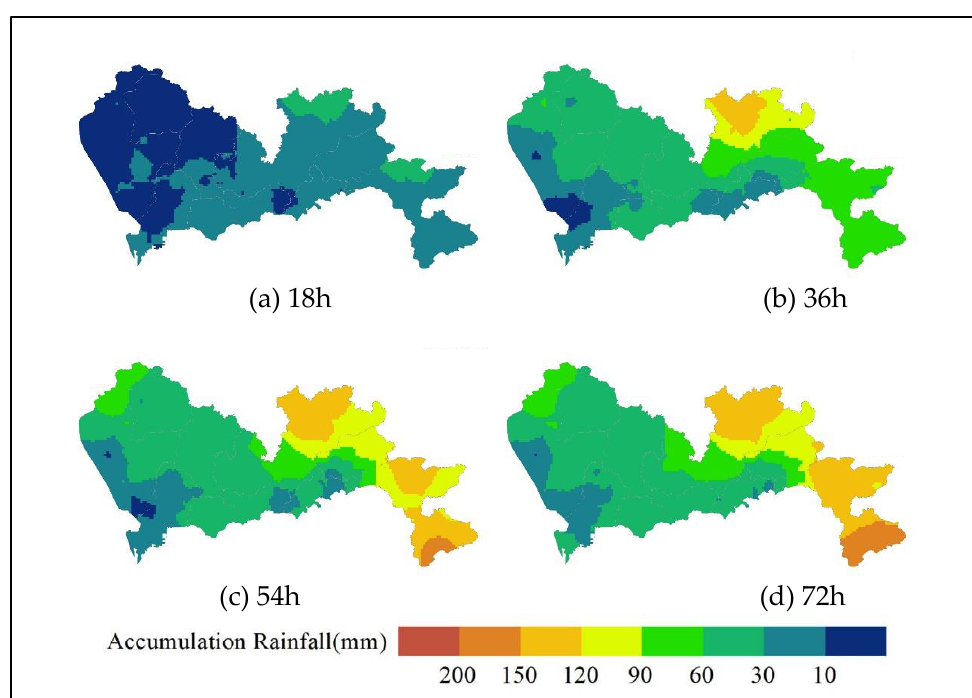
Figure 10. Temporal and spatial distribution pattern of the type III characteristics of 72 h rainfall in Shenzhen.